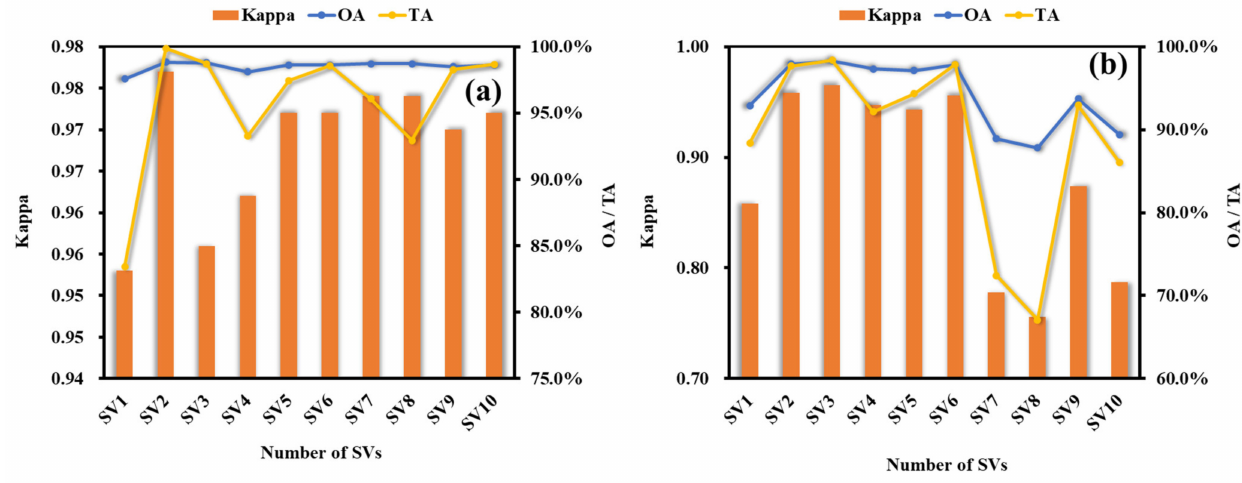
Figure 13. Accuracy of winter wheat mapping under different numbers of singular vectors (SVs), Puyang County ( a ) and Shenzhou City ( b